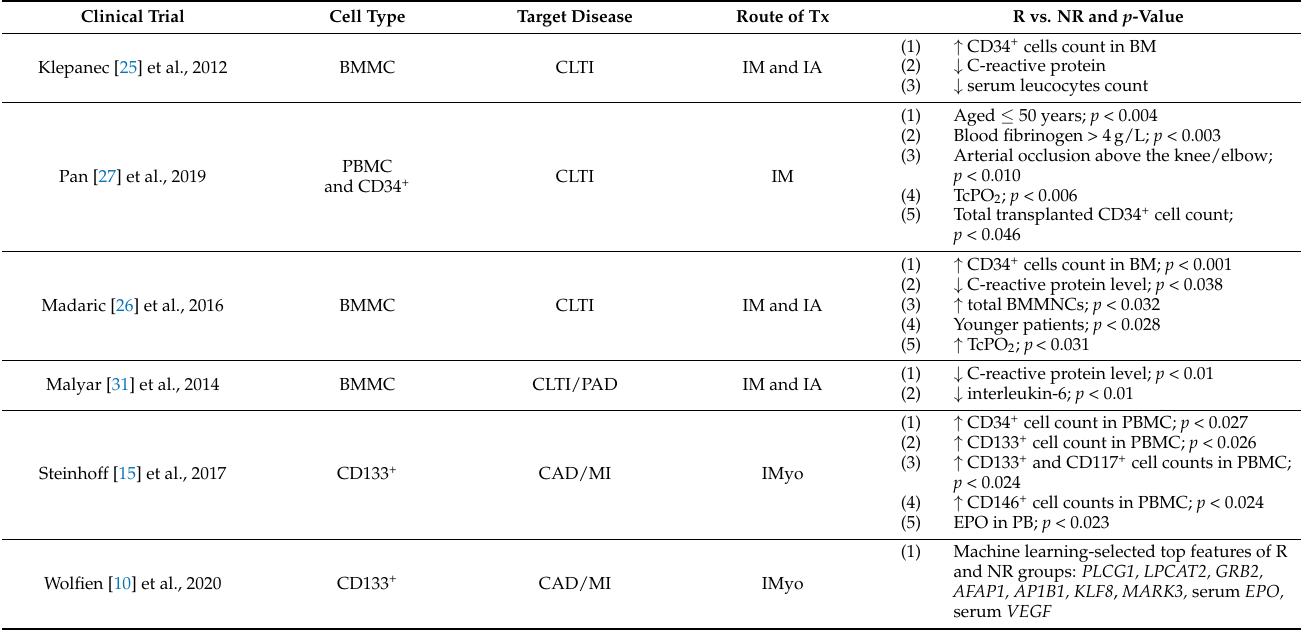
Table 3. Clinical biomarkers of R and NR groups among patients with